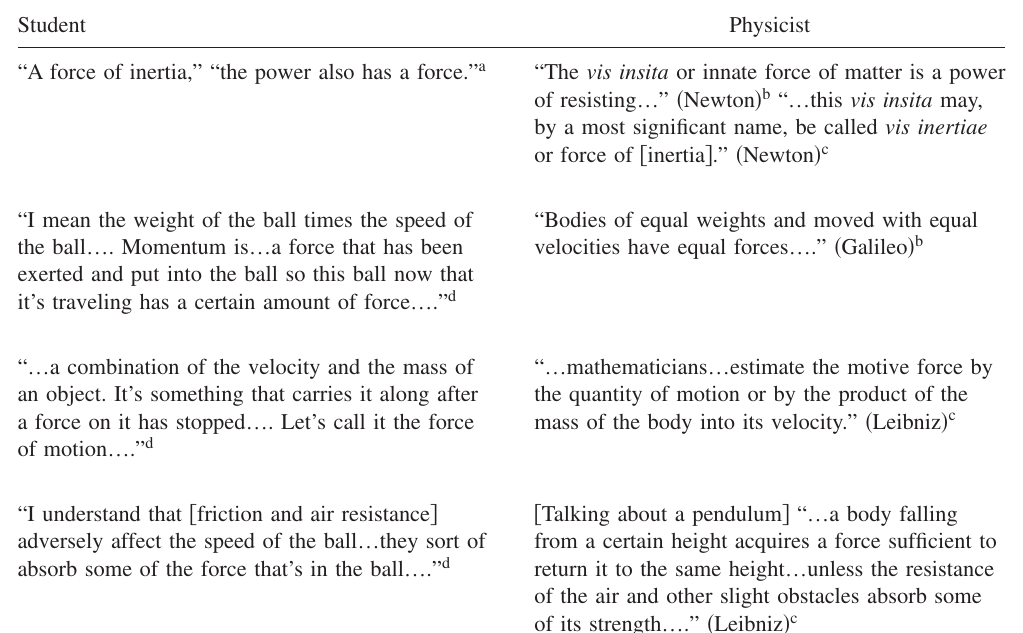
TABLE II. Comparison between inventors of mechanics and modern students.